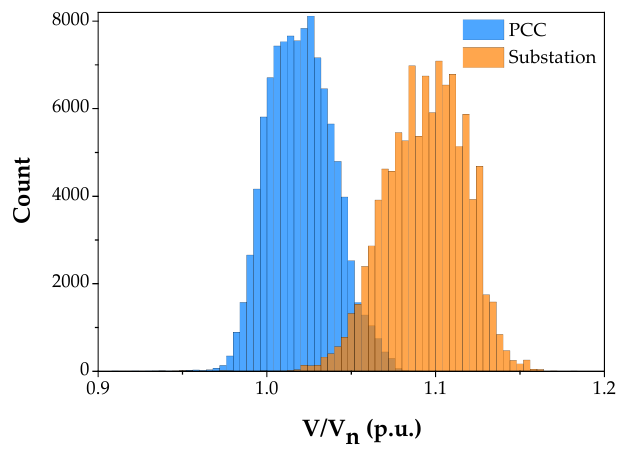
Figure 2. Voltage fluctuations in the typical 33 kV distribution line during the year (2019) . The data is measured at both substation and PCC.